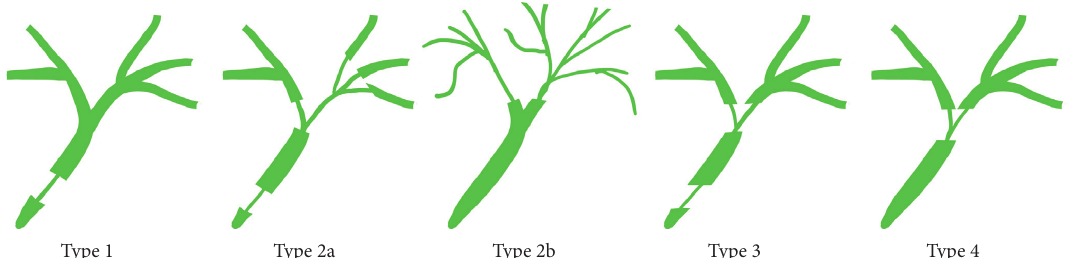
Figure 1: Schematic classification of IgG4-related sclerosing cholangitis by